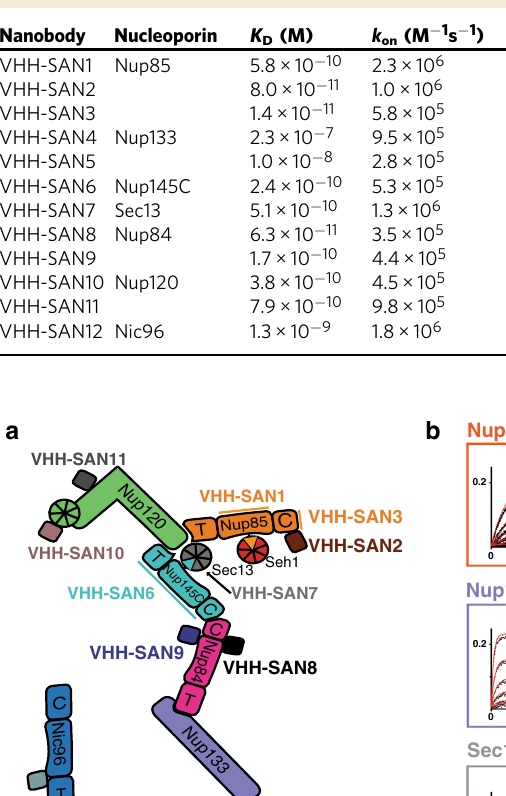
Table 1 Nanobody-binding af fi nities.